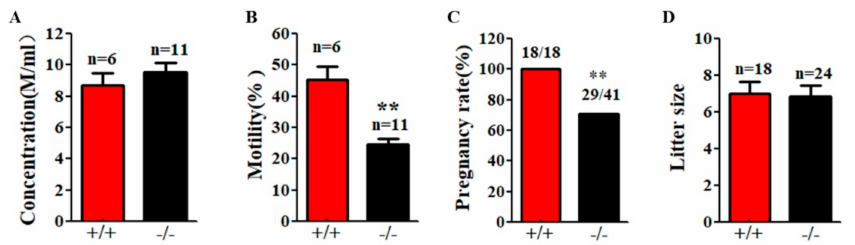
Figure 5. Motility and function defects of sperm flagella in calcium-binding protein spermatid- associated 1 knockout ( Cabs1 − / − ) mice. ( A ) Sperm concentration and ( B ) motility in male Cabs1 − / − and wild-type (WT) mice. Sperm collected from the cauda epididymitis were measured by computer- assisted sperm analysis. ( C ) Male fertility and ( D ) litter size of adult Cabs1 − / − and WT mice. Pregnancy and litter size were examined in mating cages comparing male Cabs1 − / − and WT mice over a period of 3 months. Data in bar graphs are presented as mean ± SE. ** p <